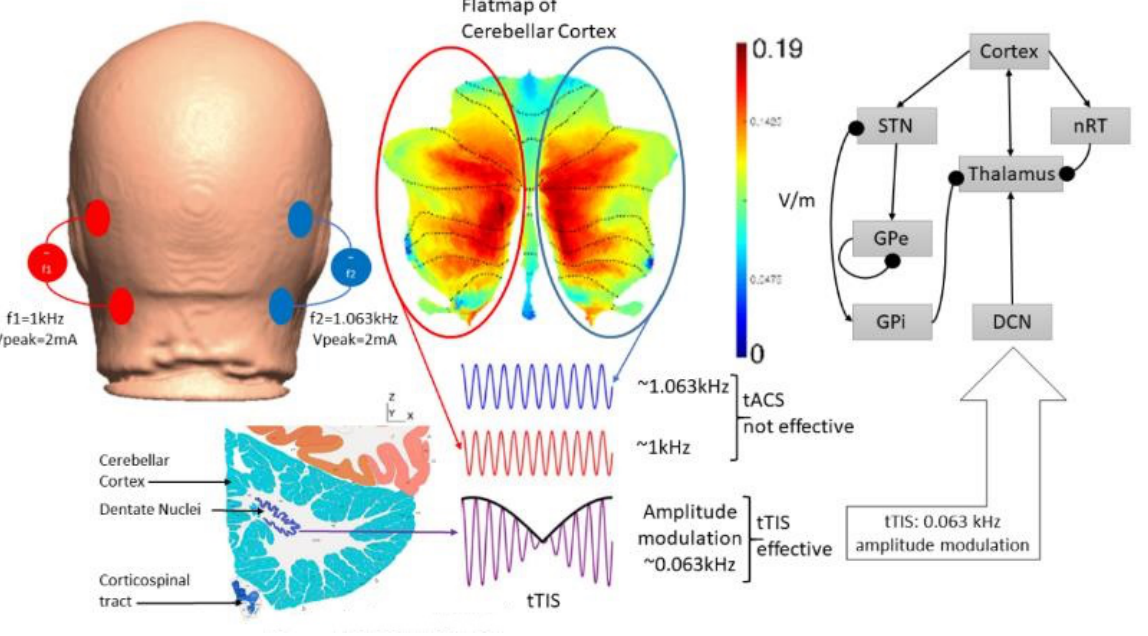
Figure 5. An illustration of the postulated transcranial temporal interference stimulation (tTIS) approach for deep cerebellar NIBS, where two tACS sources with frequencies f1 = 1 kHz and f2 = 1.063 kHz are combined for amplitude modulation at 0.063 kHz in the deep cerebellar nuclei (DCN) regions. The thalamocortical basal ganglia network with DCN from [104] is presented for tTIS modeling; arrows denote excitatory connections and round arrowheads denote inhibitory connections.